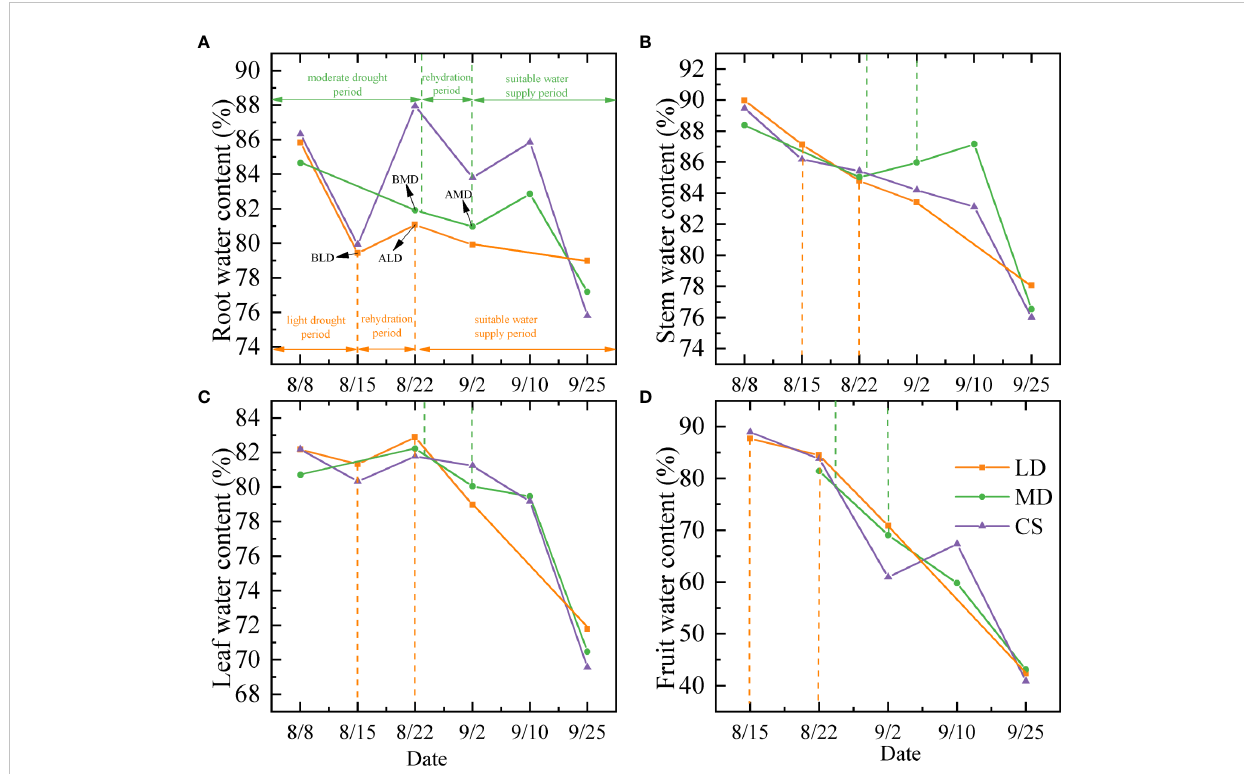
FIGURE 2 Analysis on dynamic changes of the water content in component organs of summer maize under different drought conditions. (A – D) are the dynamic changes of the water content in the root, stem, leaf, and fruit of summer maize, respectively. LD, MD, and CS represent the light drought treatment group, moderate drought treatment group, and control treatment group,